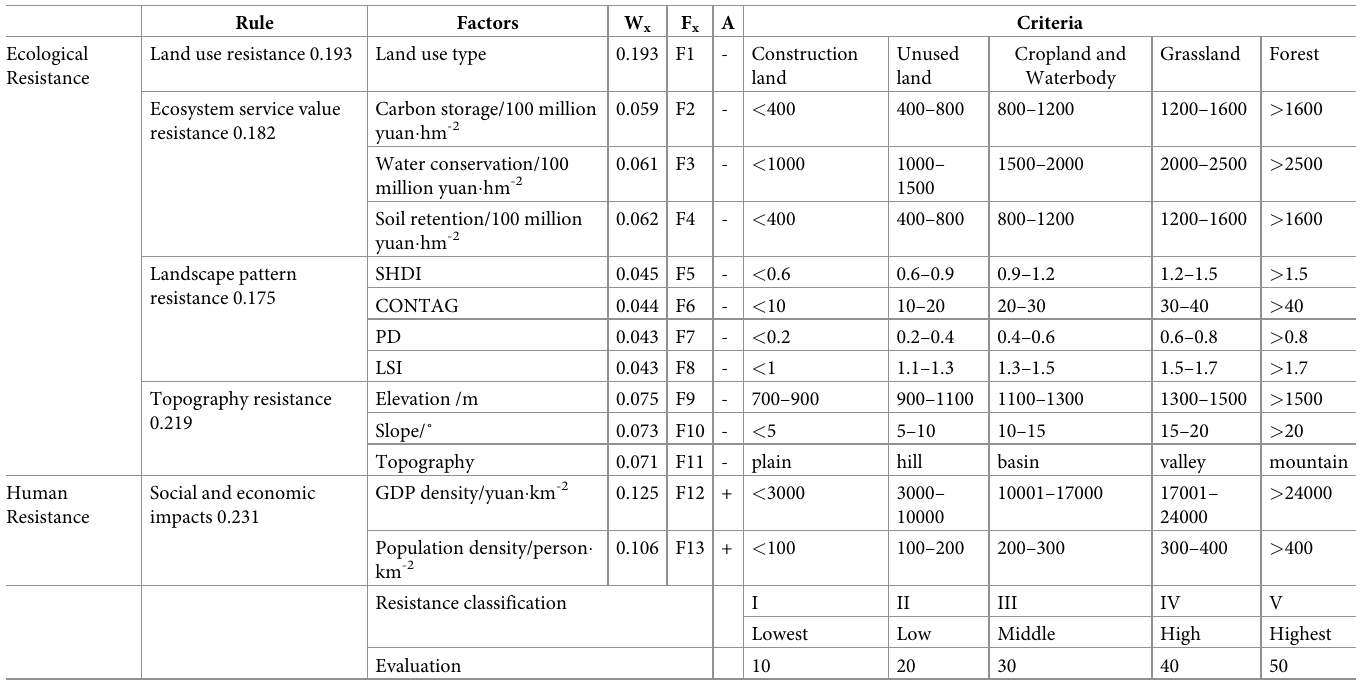
Table 1. Classification standards of resistance to development of ethnic